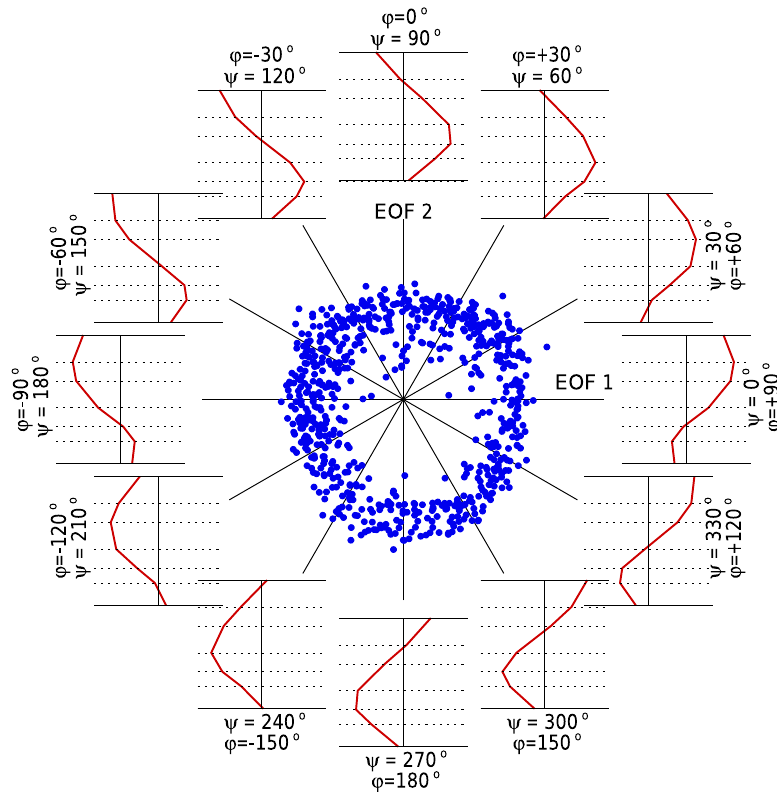
Figure 2. EOF phase-space diagram. Each dot indicates a month in the period 1958–2016. The position (angle) of the dot indicates the closest combination of the two EOFs that characterize the vertical profile of the QBO zonal wind anomaly in that month. The distance from the origin represents the amplitude r (see text). Representative vertical profiles are provided to show the typical vertical wind profile for that value of φ . The pressure levels shown in each vertical profile panel are 70, 50, 40, 30, 20, 15 and